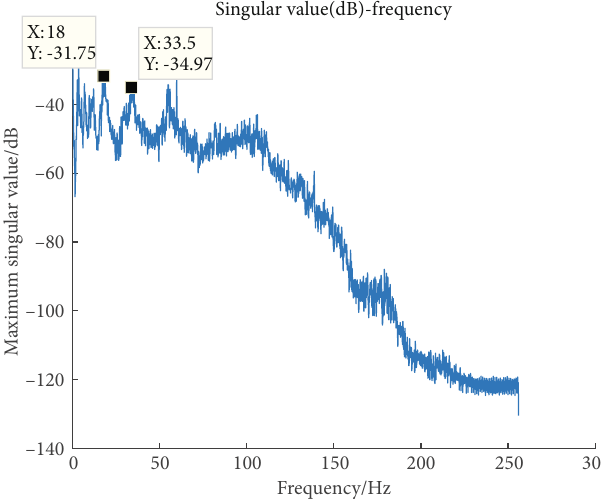
Figure 23: Maximum singular value of the